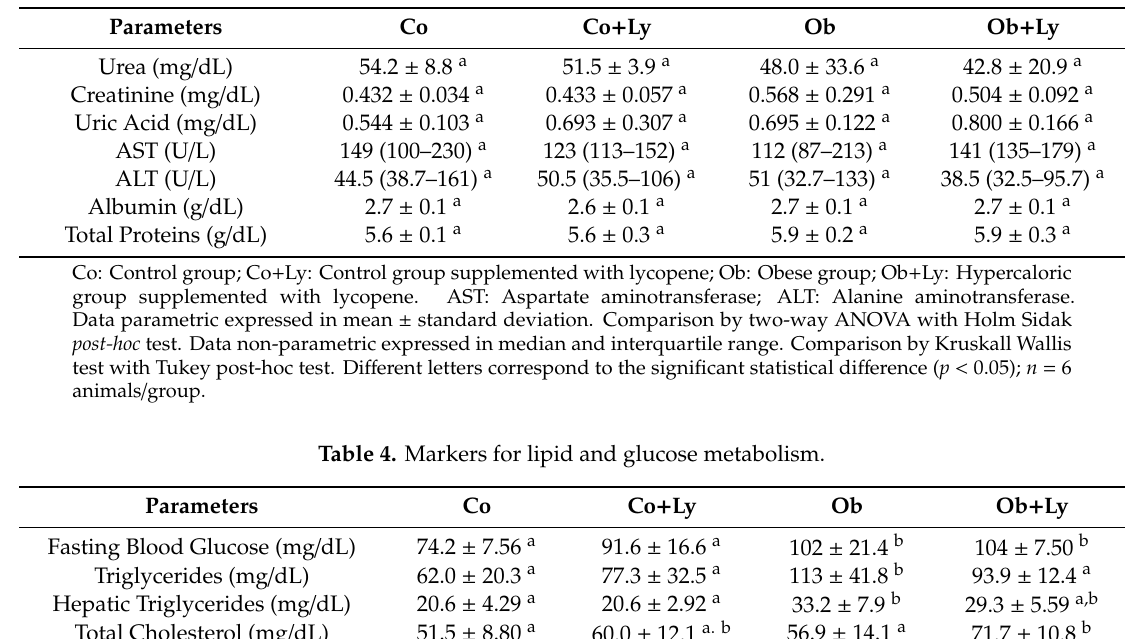
Table 3. Markers for clinical biochemistry.